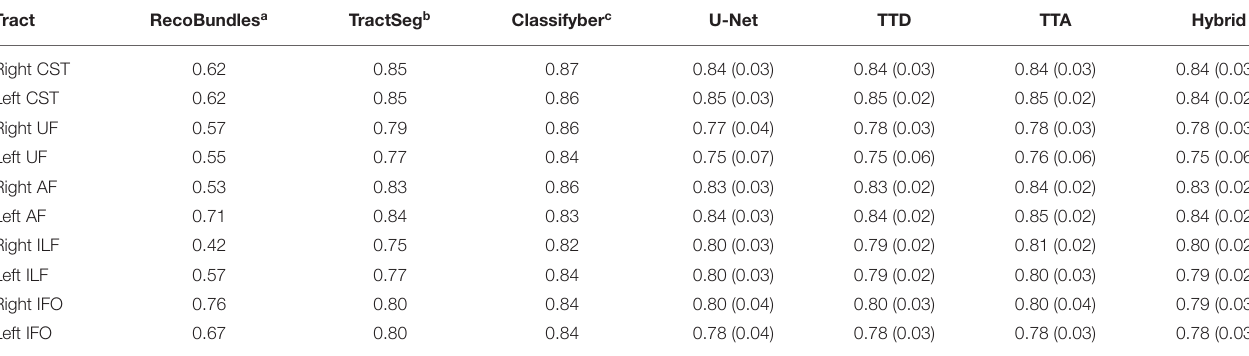
TABLE 2 | Comparison with state-of-the-art approaches for the following 5 tracts from both left and right sides of the brain: arcuate fascicle (AF), corticospinal tract (CST), inferior fronto-occipital fascicle (IFO), inferior longitudinal fascicle (ILF), and uncinate fascicle (UF).